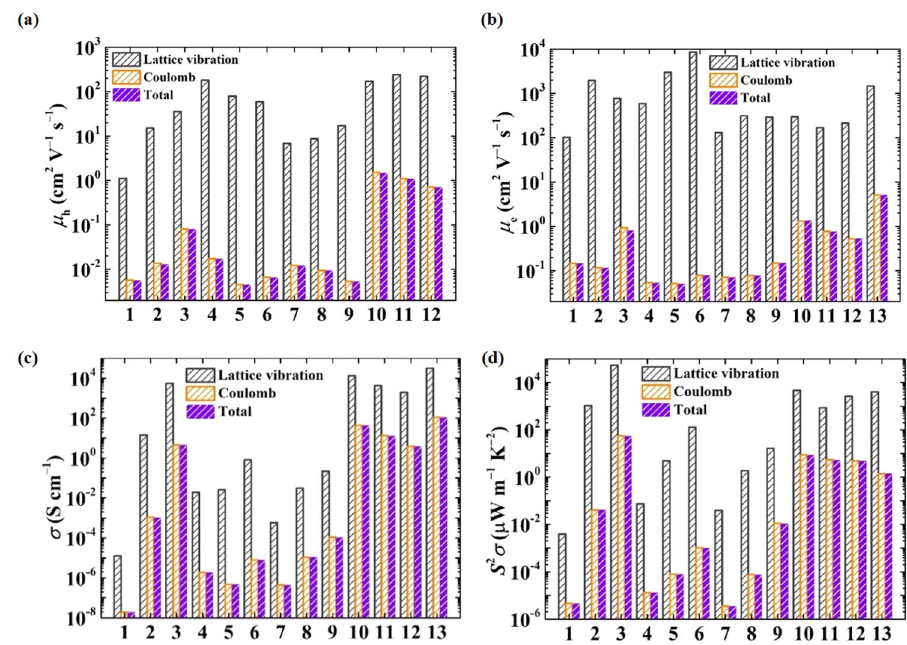
Fig. 4 Competition between the lattice vibration scattering and the Coulomb scattering in the charge and TE transport. The contributions of lattice vibration scattering (dark gray) and those of Coulomb scattering (orange) to the calculated a hole mobility ( μ h ), b electron mobility ( μ e ), c conductivity ( σ ), and d power factor ( S 2 σ ) at room temperature for our studied organic donor – acceptor